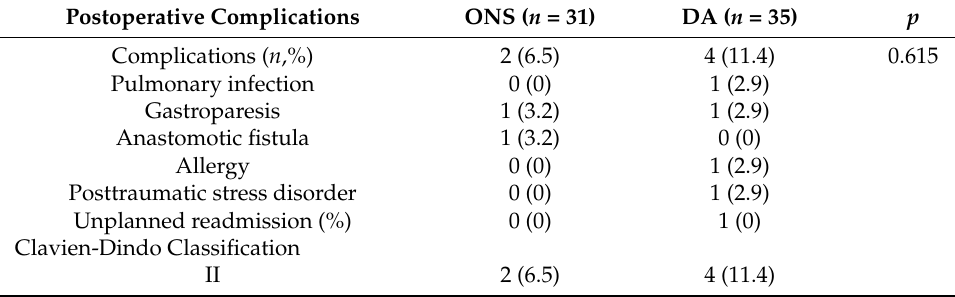
Table 3. Incidence of short-term complications and readmission rate.